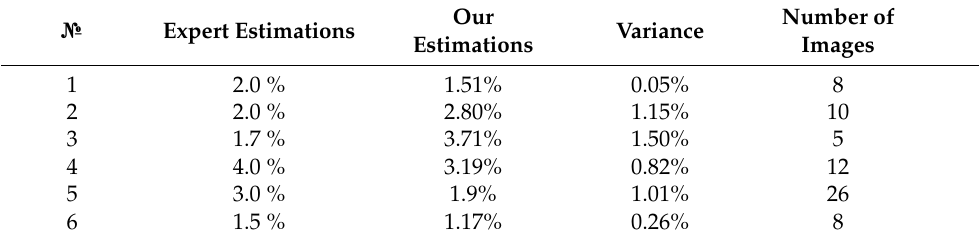
Table 3. Asbestos productivity estimation before the graduation for dataset № 3.